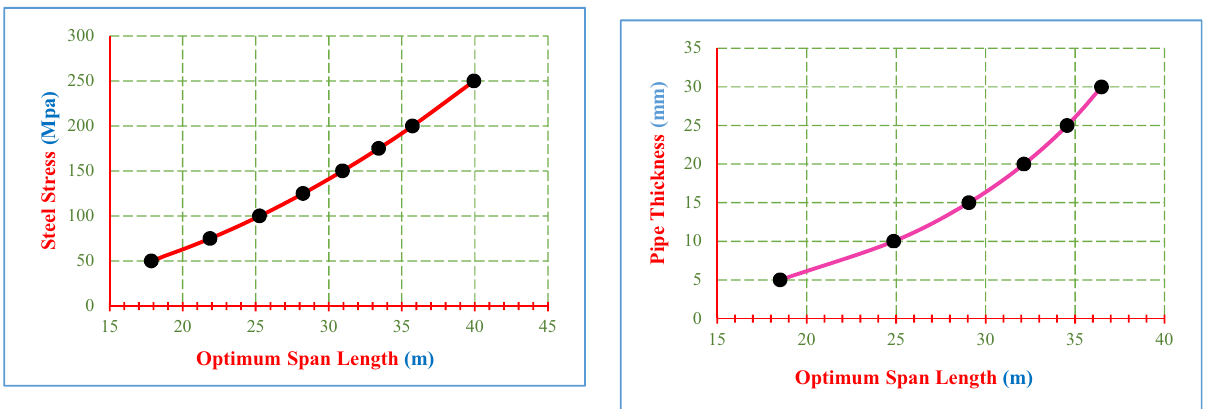
Figure 16: Pipe thickness vs safe span